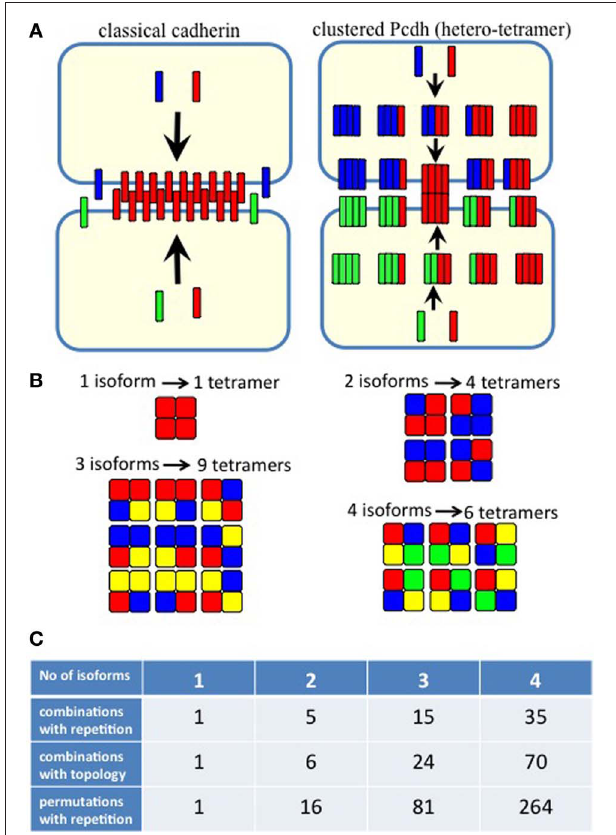
FIGURE 5 | (A) Homophilic cell adhesion as achieved by classical cadherins versus the cis -tetramers of clustered Pcdh isoforms. Red bars represent the common type of cadherin or clustered isoform molecules expressed on and binding between two interacting cells. Blue and green bars show additional cadherins or clustered Pcdh isoforms that are differentially expressed in the interacting cells. From two clustered Pcdh isoforms, five types of cis -tetramers can be produced in combination with repetition. In this example, only the red cis -tetramers can bind homophilically. (B) Variations of heteromultimeric cis -tetramers from each combination. One, two, three, and four isoforms can form 1, 4, 9, and 6 possible combinations, respectively, with repetition and topological variation. (C) Table shows the number of possible cis -tetramers from i isoforms calculated by combinations with